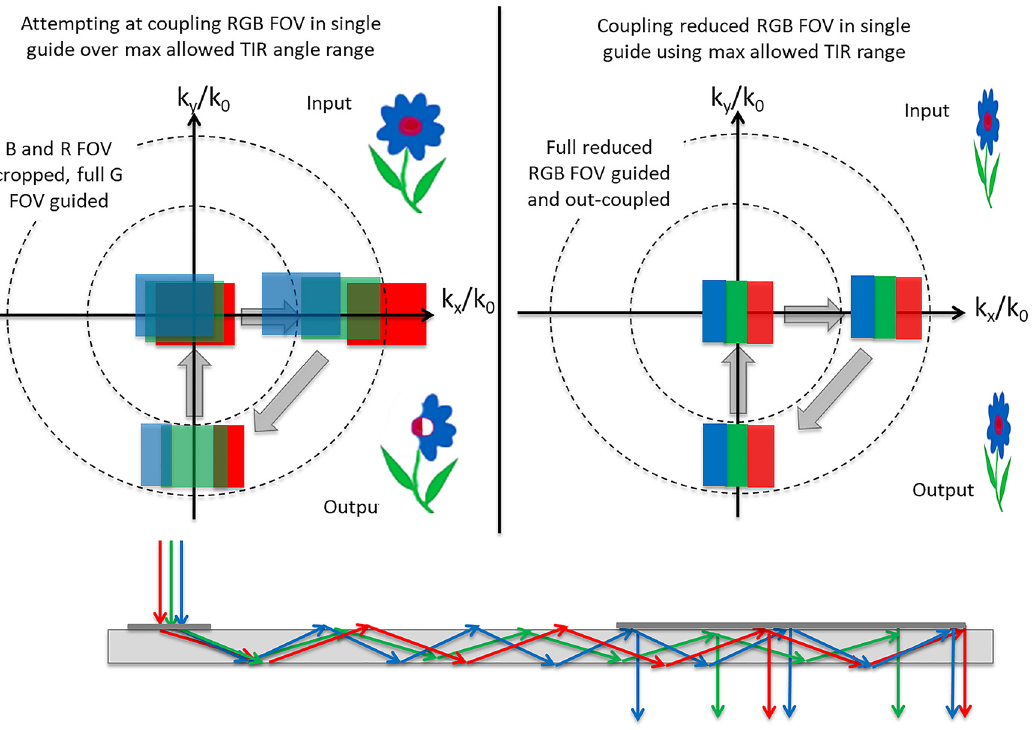
Figure 33: k -vector diagram of a single-plate waveguide combiner using (a) RGB FOV coupling over a single-color TIR angular range condition and (b) RGB reduced FOV sharing the same TIR range.